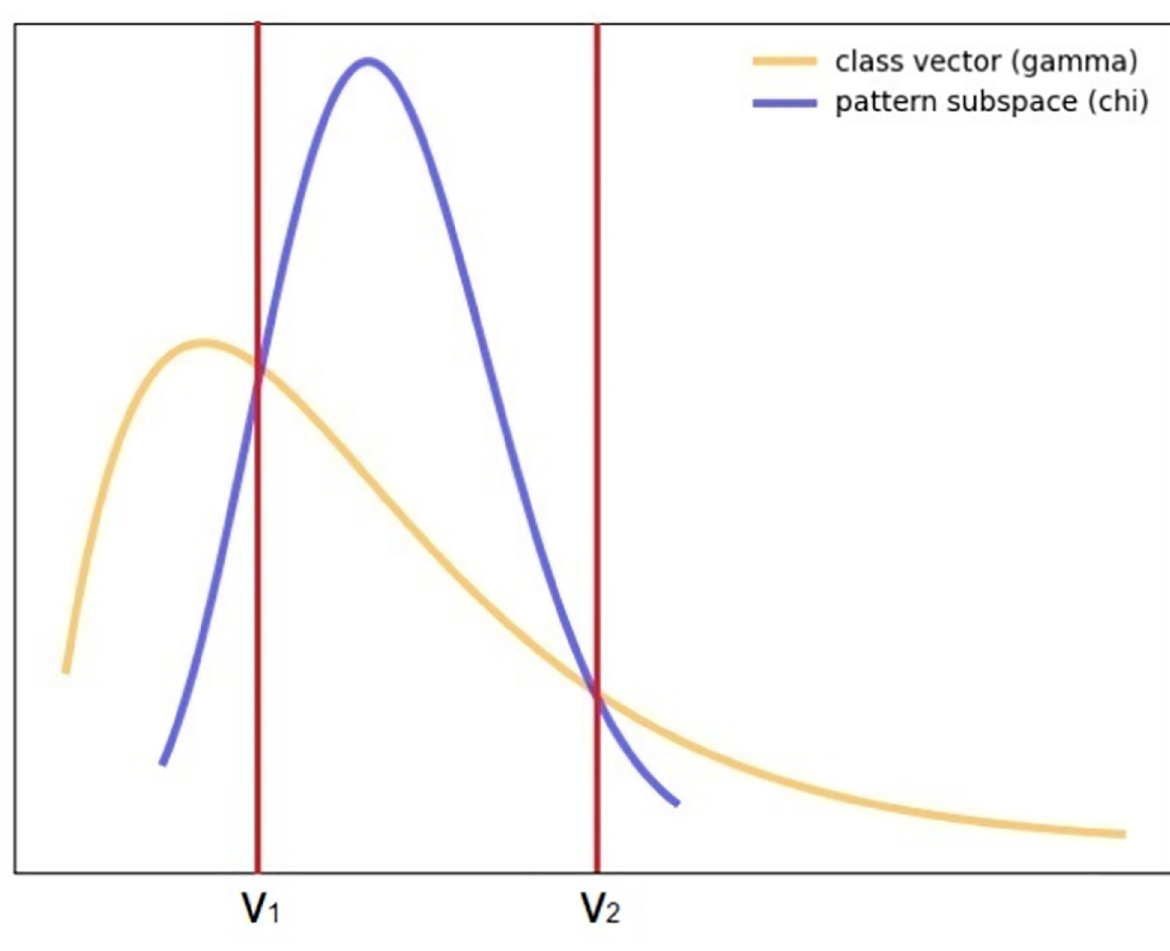
Fig 2. Intersection of two theoretical distributions. The yellow line represents the outcome variable, which follows a gamma distribution; The blue line represents the pattern-conditional outcome variable, which follows a χ 2 distribution. In this example, the two points of intersection between the distributions form an interval, [ v 1 , v 2 ]. Observations with the targeted pattern have higher likelihood to have numerical outcomes in the extracted